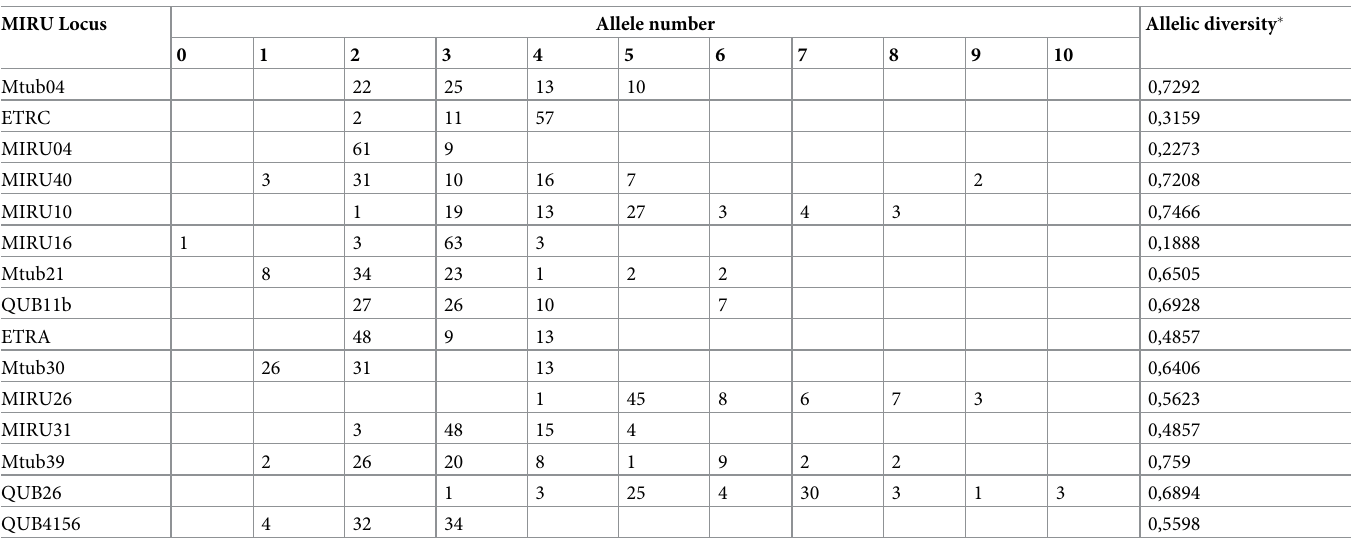
Table 3. Allelic polymorphism of 15 MIRU loci assessed on 70 MDR MTB strains. MIRU